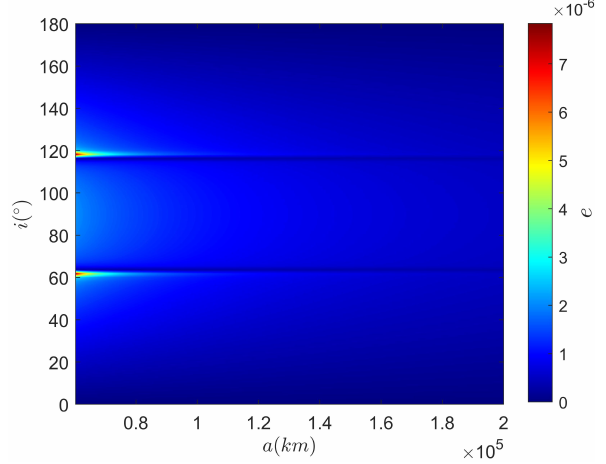
Figure 9. The eccentricity e for different value of semi major axis a and inclination i when ω = 270